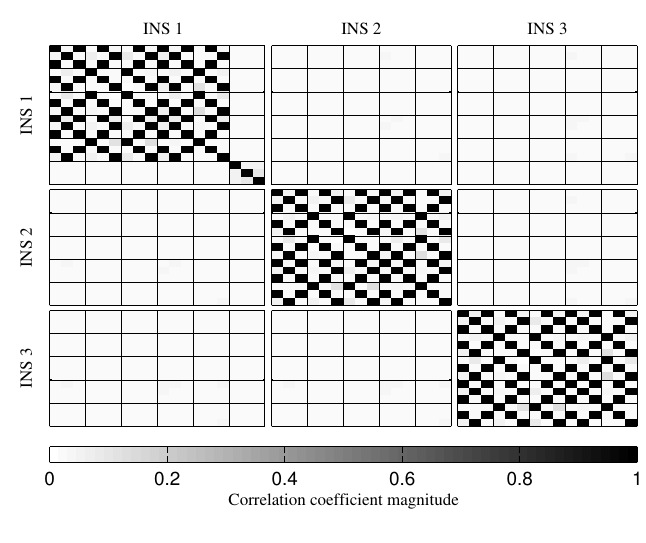
Figure 16. Graphical represetation of the correlation between the states of the navigation filter at the 30th second of the simulation, when only the relative attitude constraint is present.